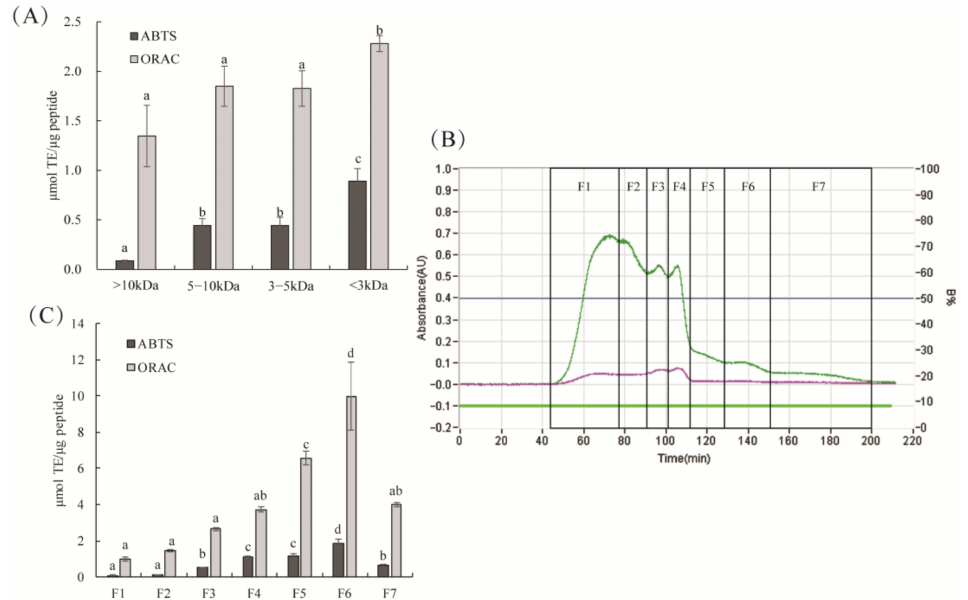
Figure 2. The antioxidant activity of ultrafiltration fractions ( A ). Fraction <3 kDa with the strongest antioxidant activity was separated by Sephadex G-15 gel ( B ). Seven fractions were collected, and